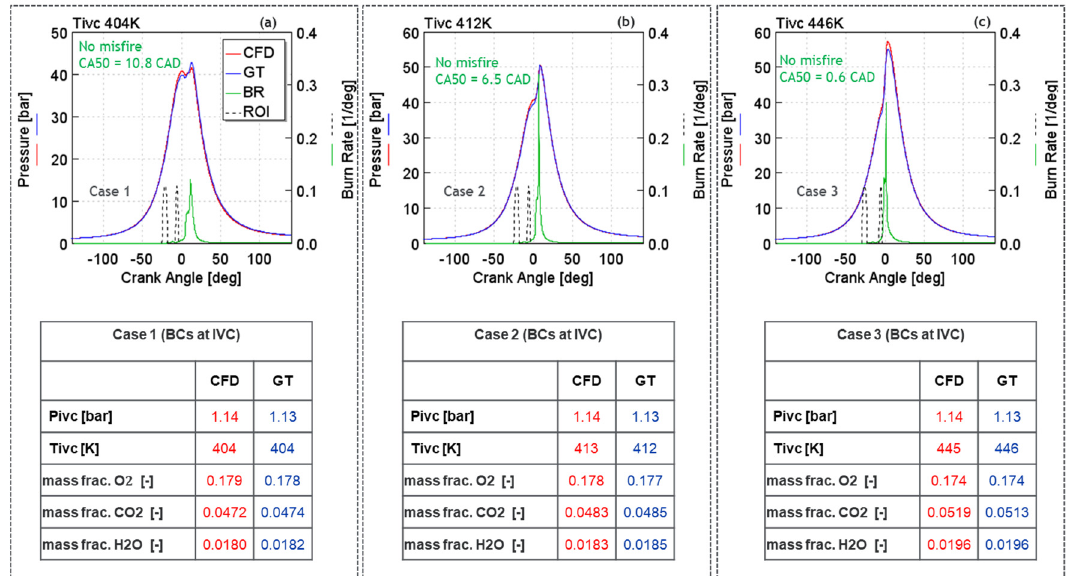
Figure 8. In-cylinder pressure traces and air-thermal boundary conditions comparison between 1-D and 3-D CFD models for ( a ) Tivc 404 K, ( b ) Tivc 412 K and ( c ) Tivc 446 K.